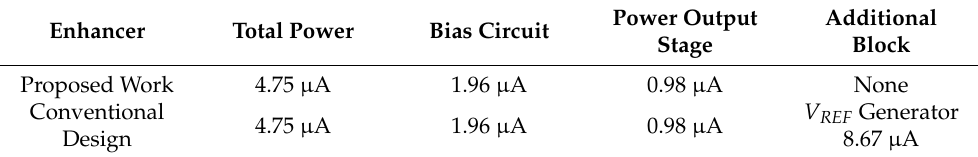
Table 3. Power allocation in proposed and conventional enhancer with 1.2 V supply voltage.